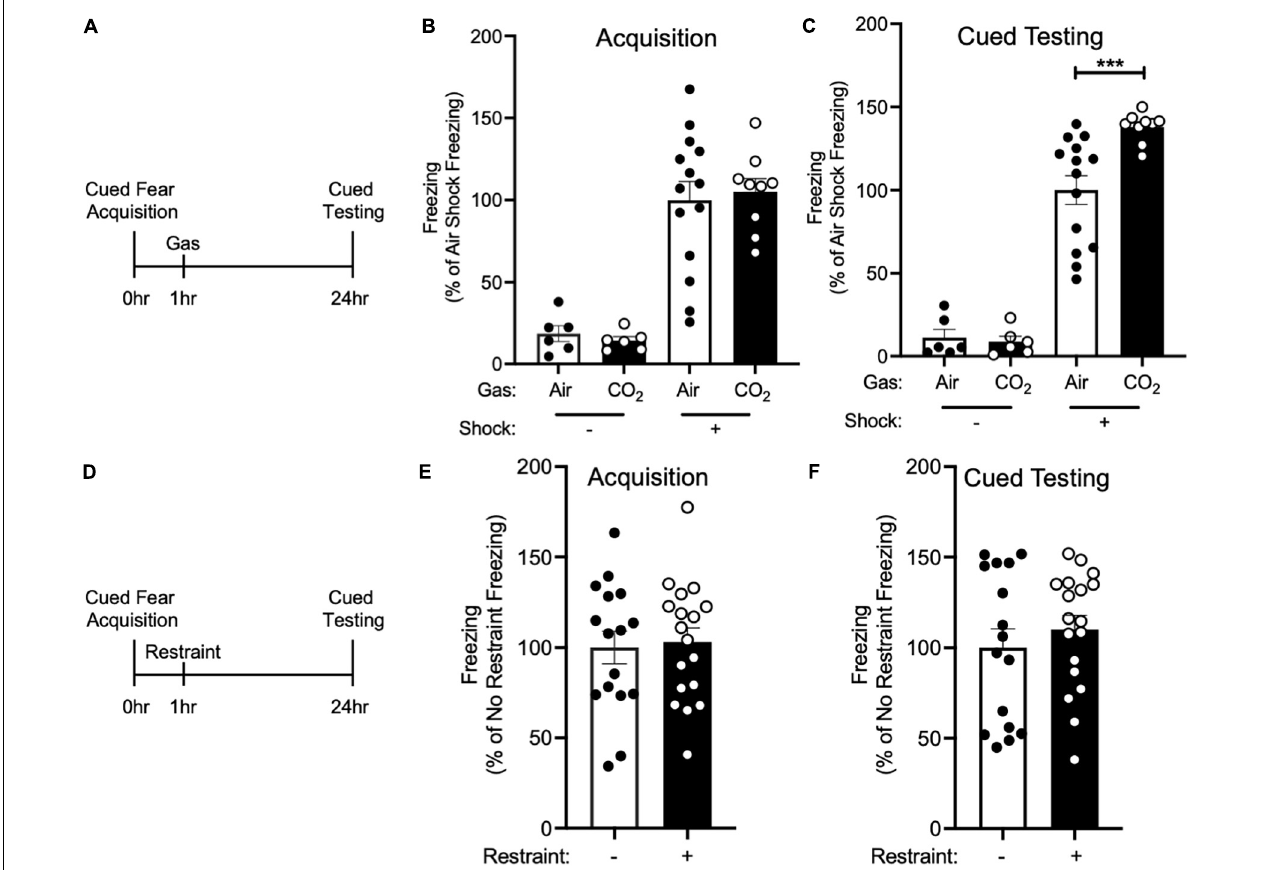
FIGURE 1 | CO 2 Inhalation after cued fear conditioning enhances fear memory. (A) Experimental timeline. 1 h after cued fear acquisition, mice were exposed to air or 10% CO 2 for 30 min. 24 h after acquisition, cued fear memory was assessed. (B) During acquisition, much less freezing was observed when foot shocks were omitted from the training protocol [effect of shock, two-way ANOVA F (1, 31) = 61.22, p < 0.0001, n = 6–14]. Freezing in mice assigned to Air and CO 2 treatment was similar in both the no shock ( p = 0.8135) and shock groups ( p = 0.6957). (C) On the cued fear test day, robust freezing to the tone was observed in mice who had received foot shocks during acquisition and this freezing was enhanced by CO 2 treatment [gas by shock interaction, two-way ANOVA F (1,31) = 6.389, p = 0.0168]. Planned contrast testing revealed a robust effect of CO 2 treatment in mice that had received foot shocks during acquisition (*** p = 0.0004), whereas in contrast, CO 2 treatment had no effect on freezing in the no shock control group ( p = 0.8453). (D) Experimental timeline. 1 h after cued fear acquisition, mice were placed in a restraint tube for 30 min or left in the home cage. 24 h after acquisition, cued fear memory was assessed. (E) Freezing during acquisition was similar in both treatment groups [ t (32) = 0.2560, p = 0.7996]. (F) Freezing during cued fear testing was not altered by restraint stress [ t (32) = 0.7850, p =